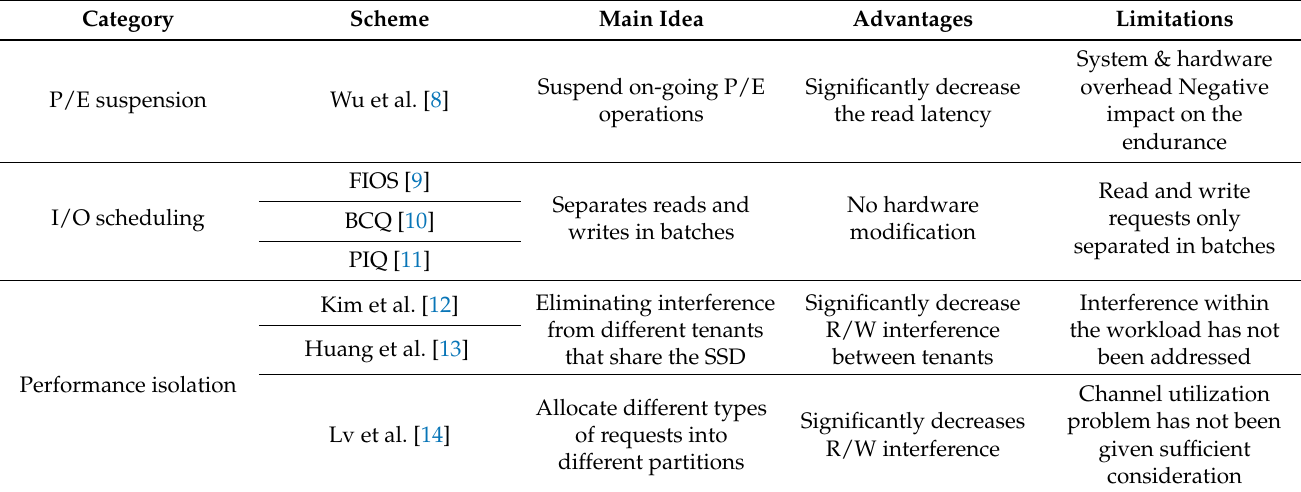
Table 1. Summary of R/W interference mitigation